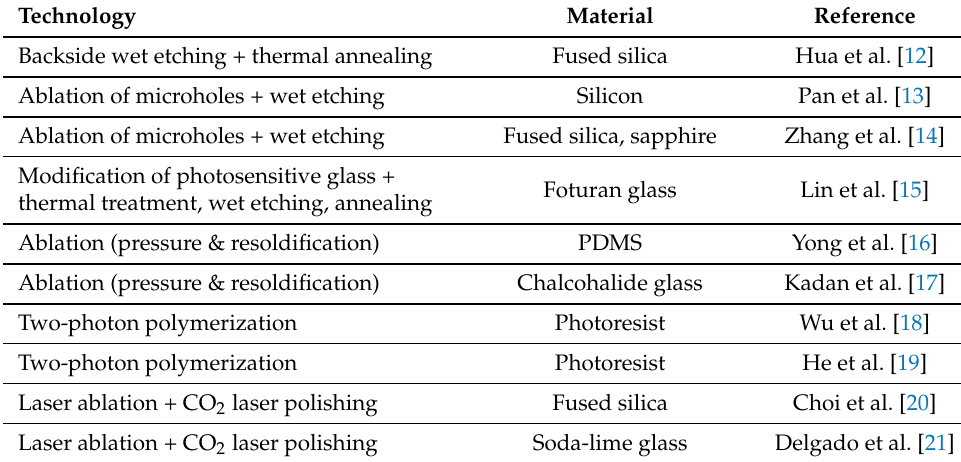
Figure 1. Schematic illustration of the beam homogenizer principle for an imaging beam homog- enizer consisting of two lens arrays (LA1 & LA2) and a Fourier lens (FL). The incoming intensity distribution is transferred into a Top-Hat profile while its shape is defined by the footprint of the single lens geometry. Table 1. Femtosecond laser based optics fabrication